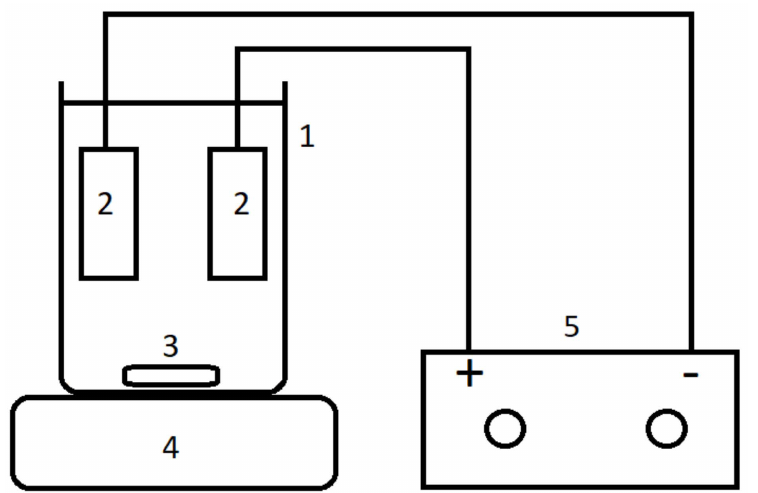
Figure 1. The schematic of the electrocoagulation setup consisting of ( 1 ) a 250 mL glass beaker, ( 2 ) 2 mild steel electrodes and ( 3 ) a stirring magnet. The beaker was placed upon ( 4 ) a stirring plate and the electrodes were connected to ( 5 ) the power